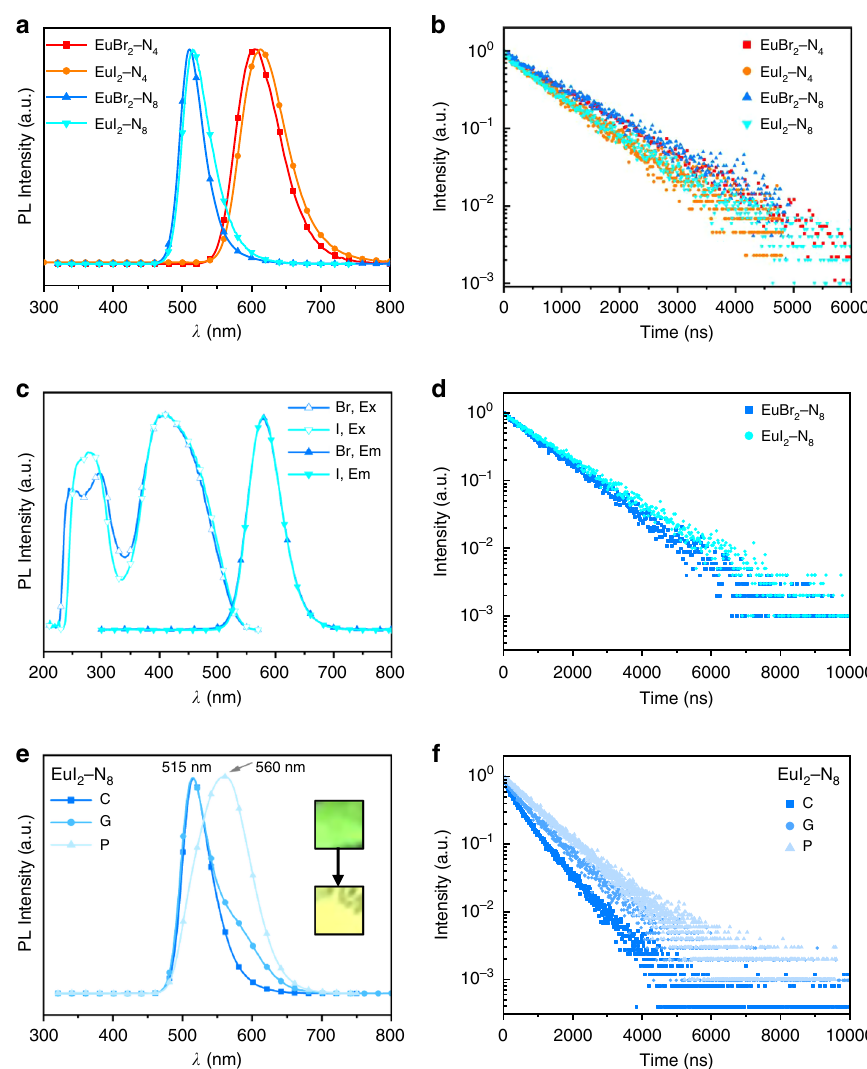
Fig. 2 The photophysical properties of Eu X 2 – N n compounds in solid and solution. a The emission and ( b ) decay spectra of solid Eu X 2 – N n ( X = Br, I, n = 4, 8). c The excitation (Ex), emission (Em), and ( d ) decay spectra of Eu X 2 – N 8 in methanol solution (1.5 mM). e The emission spectra of EuI 2 – N 8 and ( f ) the decay spectra of EuI 2 – N 8 of crystals (C), ground samples (G), and powder (P).